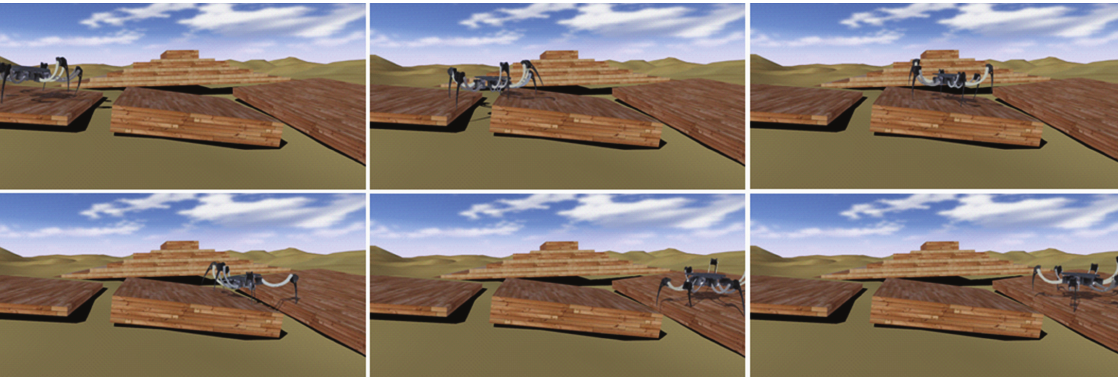
Figure 8: Pictorial representation of robot traversing through gaps of variable gap lengths using Foothold Reflex Control (FRC) method.